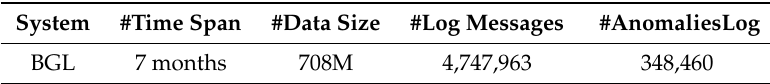
Table 4. Summary of BGL dataset.